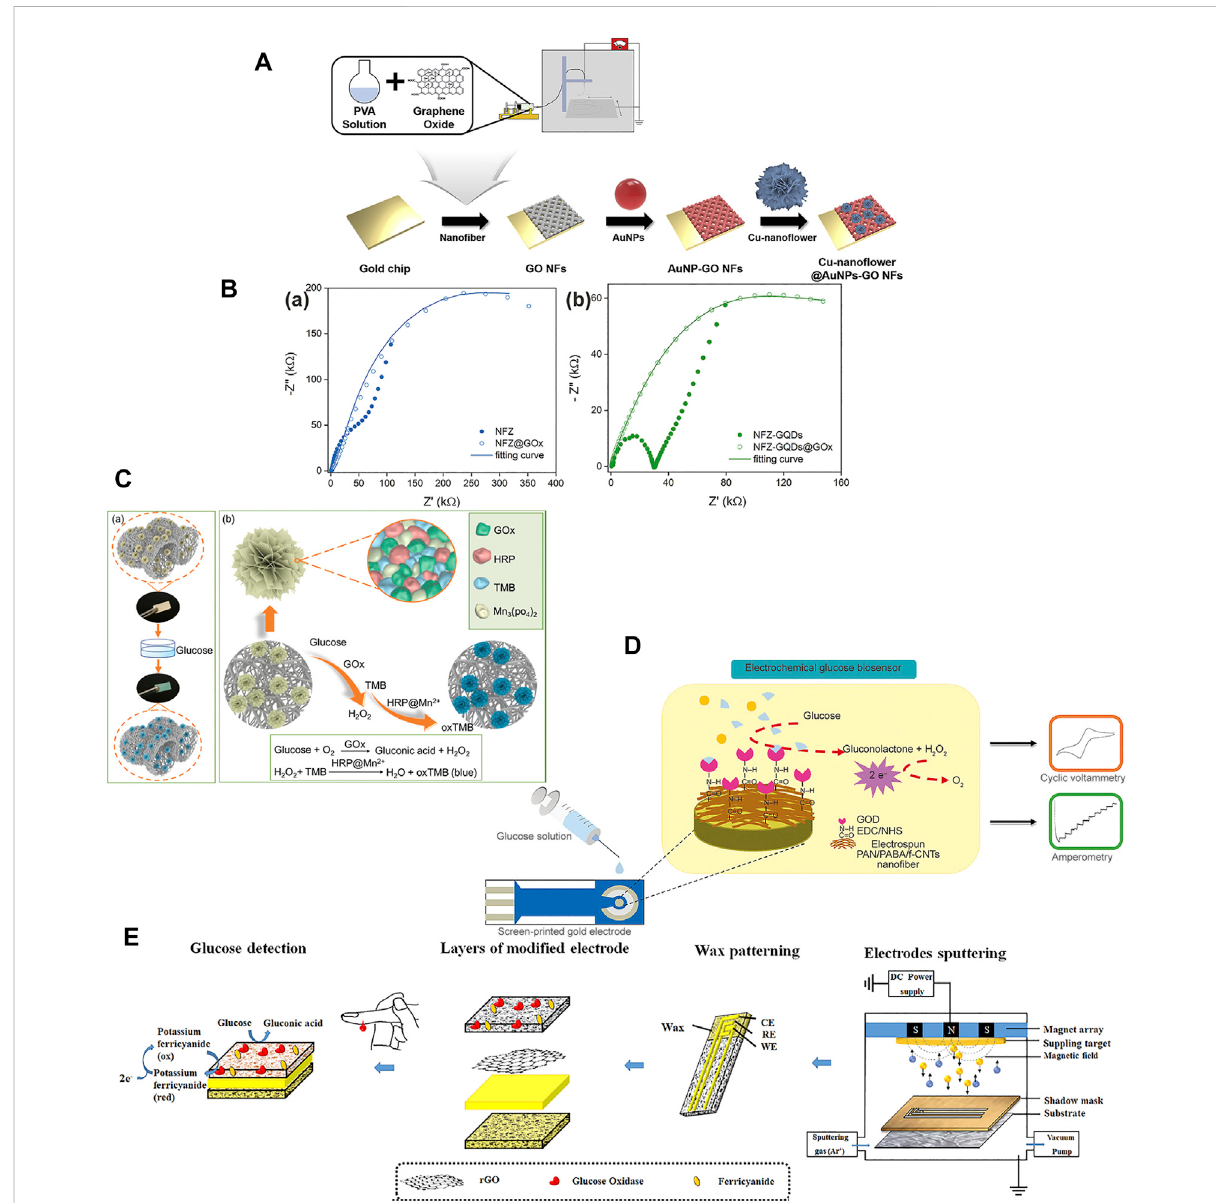
FIGURE 7 Glucose sensor loaded with nanomaterials using electrospinning technology. (A) Fabrication procedure of PVA/GO/AuNPs/GOx-HRP sensor, cysteamine-AuNPs solution wasdropped onto the surfaceof PVA/GONFs (Baeket al., 2020). (B) (a) Nyquistplots ofNFZ and NFZ@GOx. (b) Nyquist plots of NFZ-GQDs and NFZ-GQDs@GOx (Mercante et al., 2021). (C) (a) Schematic diagram of the detection process. (b) Fabrication process of GOx@HRP@TMB@Mn 3 (PO 4 ) 2 − nano fi brous strip ofcolorimetric glucosesensor,theMn 2+ adsorbedonto themembraneand formedtheGOx@